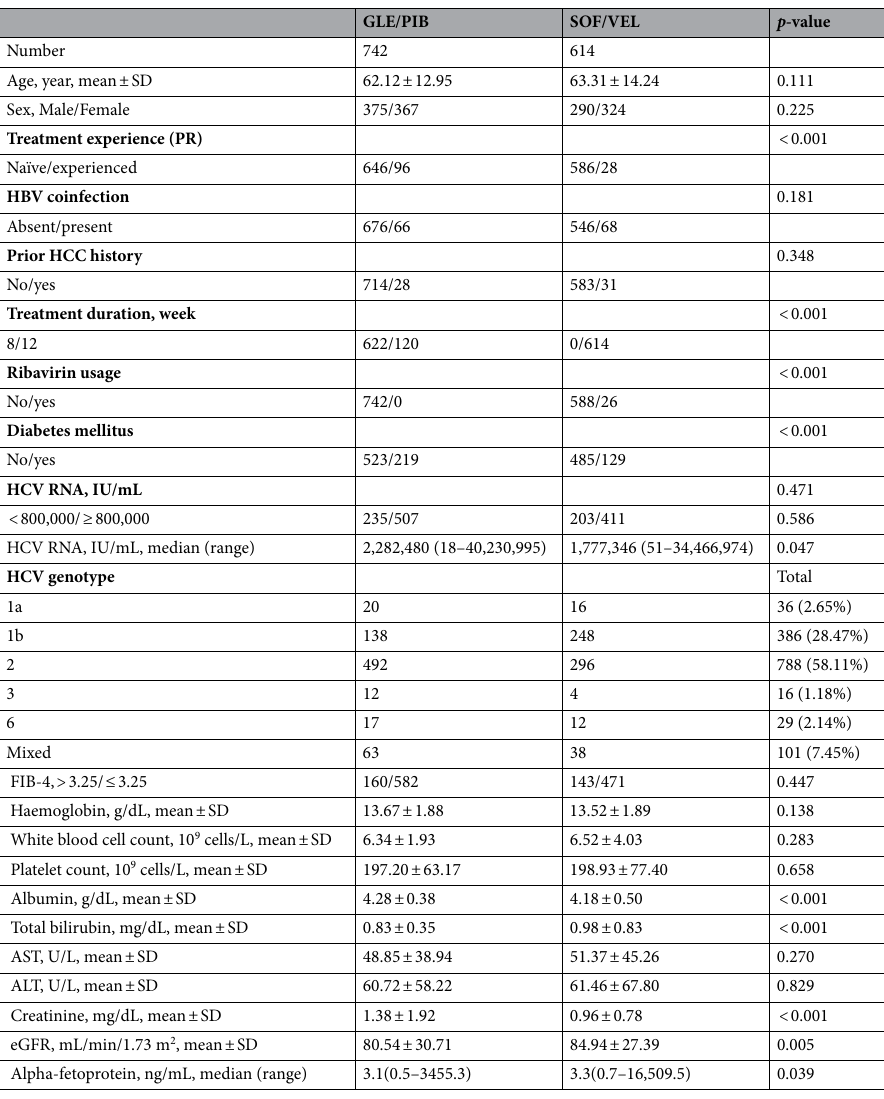
Table 1. Baseline characteristics of patients. ALT alanine aminotransferase; AST aspartate aminotransferase; eGFR estimated glomerular filtration rate; FIB-4 fibrosis index based on four factors; GLE/PIB